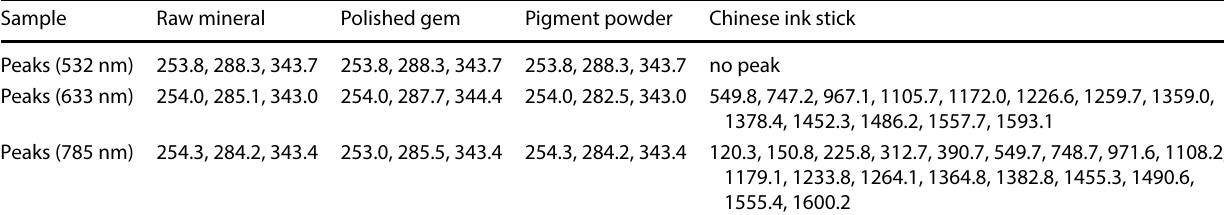
Table 3 Peak positions (cm −1 ) for different samples Sample Raw mineral Polished gem Pigment powder Chinese ink stick